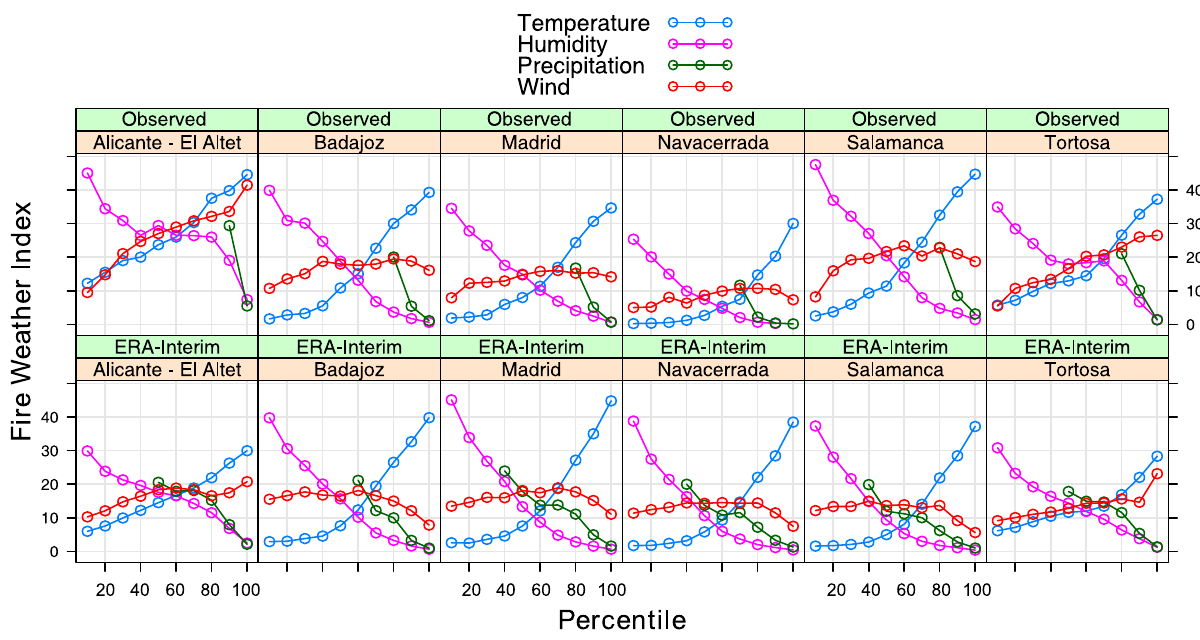
Fig. 2. Sensitivity of FWI to its input variables according to both observational data and ERA-Interim reanalysis at six locations. For each variable, the graph represents the mean FWI values (Y-axis) for those dates in different decile bins of the input variables, as shown in the X-axis labelled from 10 (values of the variable in the lowest decile) to 100 (values in the highest decile).